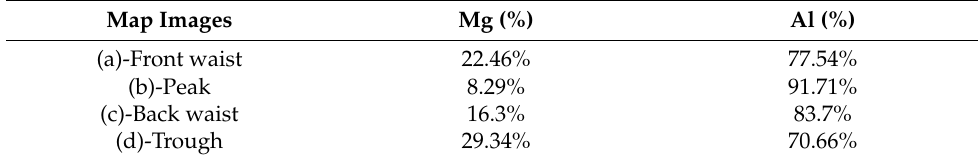
Figure 10. Element distribution of the transverse tensile-shear fractures on the Al-side of the corru- gated Mg/Al clad plate: ( a ) front waist, ( b ) peak, ( c ) back waist, ( d ) trough. Table 4. The percentage of Mg element and Al element shown in Figure